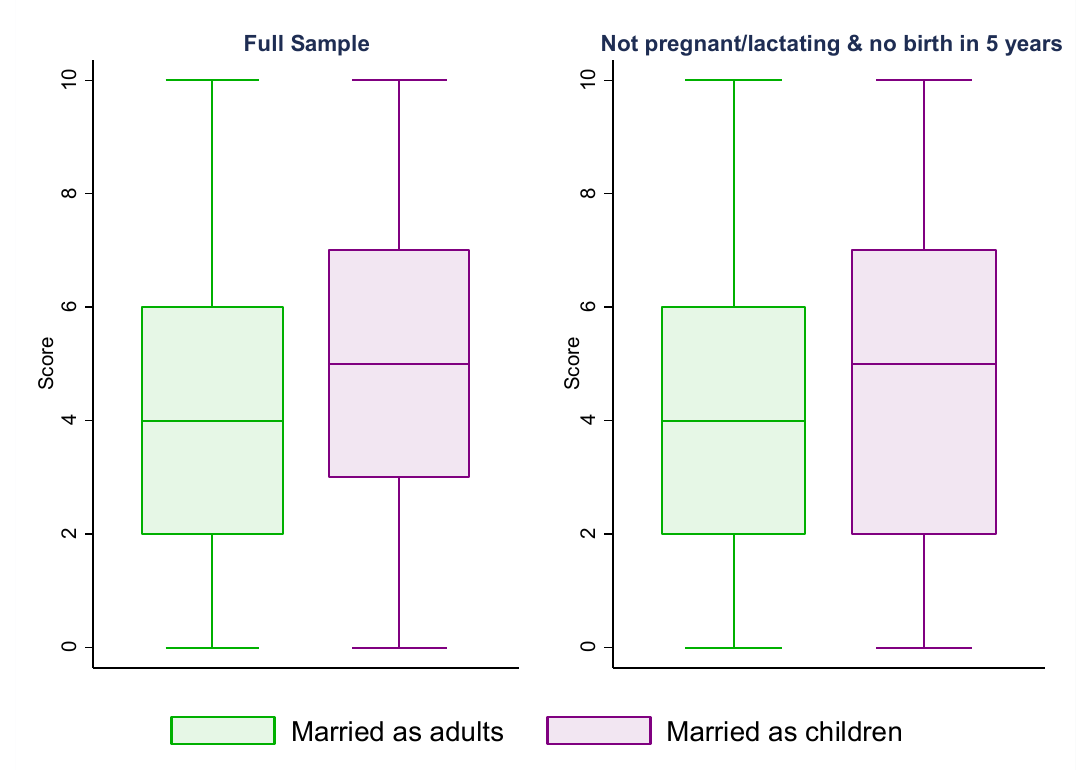
Figure 2. Relationship between marriage age and 11-point score.